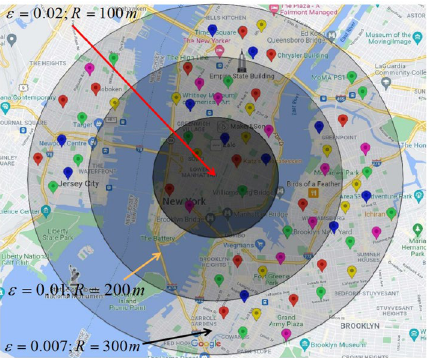
Figure 4. Variations of perturbation area with privacy parameter ε . Geo-information obtained via Google Maps (https:// www. google. com/ maps, Latitude: 40.7185036, Longitude: − 73.9648126, Elevation: 13.02) and POI with different semantic information have been marked manually with different